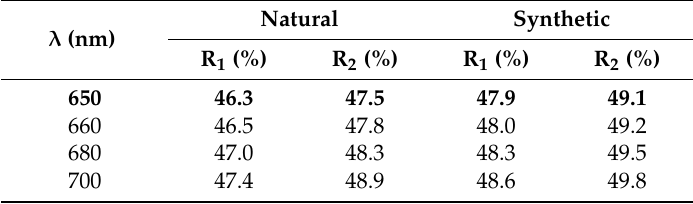
Table 2. Electron-microprobe analyses of natural and synthetic thalhammerite.